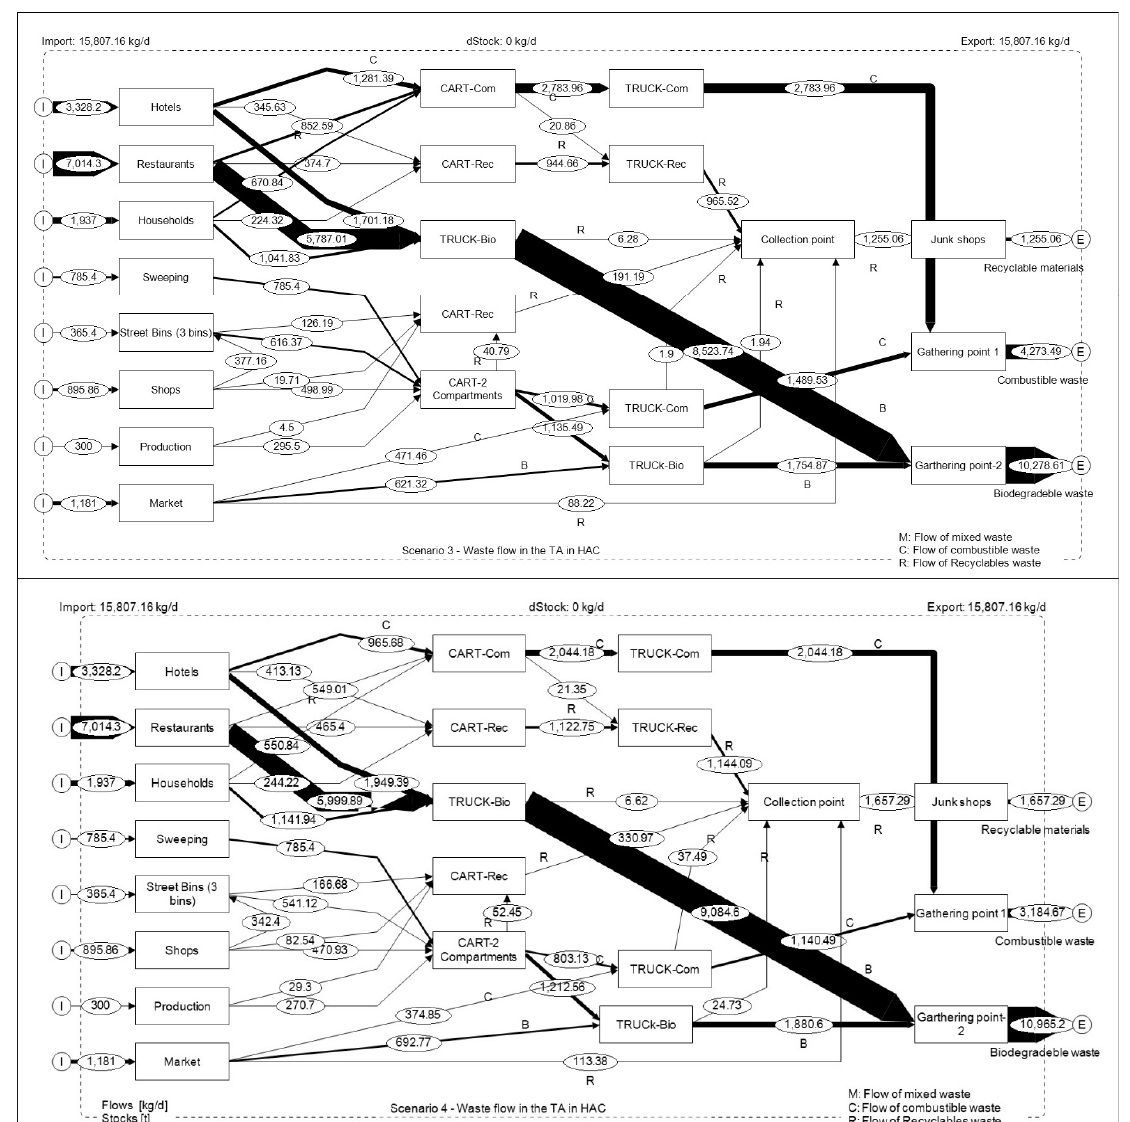
Fig. 4: Waste flow of S3 and S4